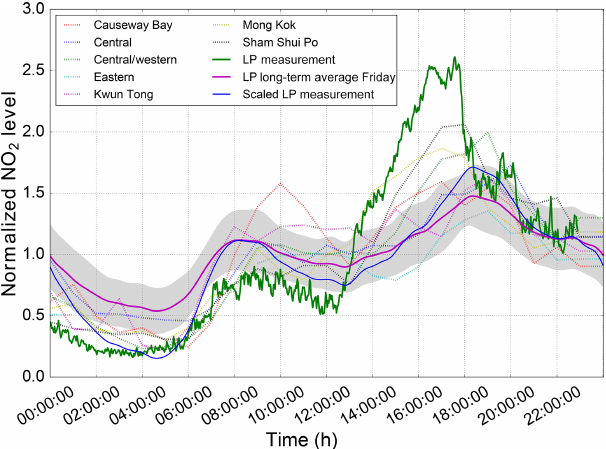
Figure 5. Normalized diurnal cycle of NO 2 on Friday in Hong Kong in 2010 measured by the LP-DOAS and EPD monitoring stations. EPD measurements on 17 December 2010 from seven monitoring stations are indicated as a dashed line. The green curve represents LP-DOAS measurement, while the purple line is the 2-year aver- aged diurnal pattern with shaded area of the 1 σ standard deviation variation. The blue line shows the scaled and shifted diurnal pattern of ambient NO 2 on Friday 17 December